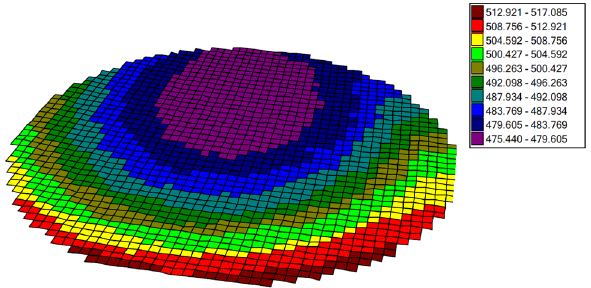
Figure 2. Map of the SiN layer thickness after the deposition process using the LPCVD method (red dotted line shows cleave direction).